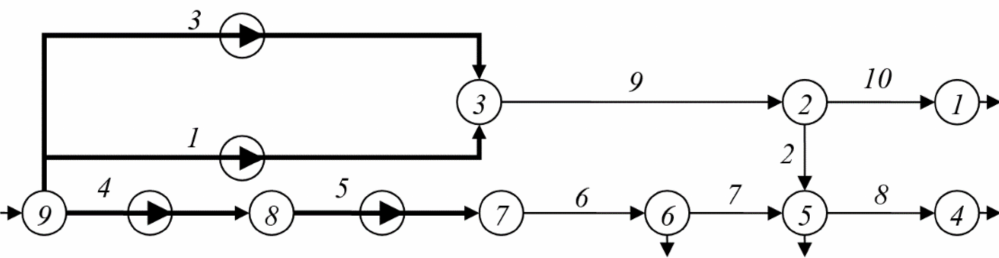
Figure 4. Scheme of a gas transmission system. Thick lines correspond to a compressor, thin lines—to pipeline sections.